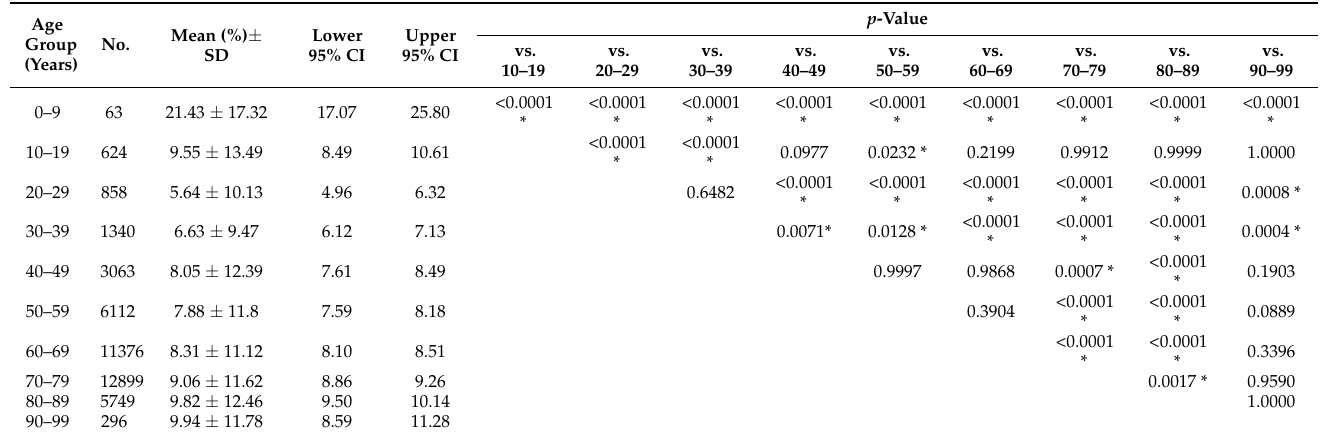
Table 3. Comparison of FLs among age-stratified groups.